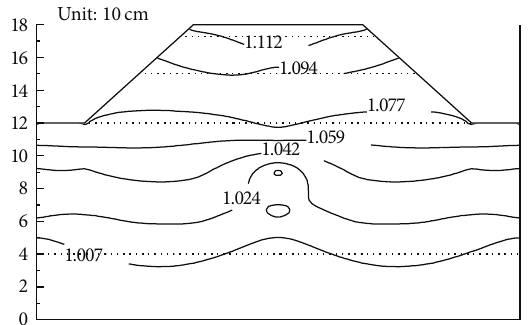
Figure 6: At 0.030 g loading acceleration.